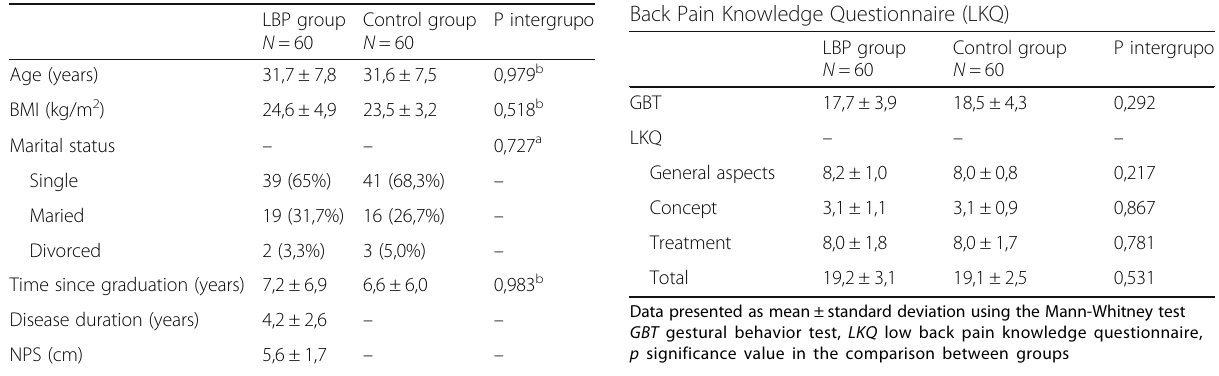
Table 1 Sample characteristics